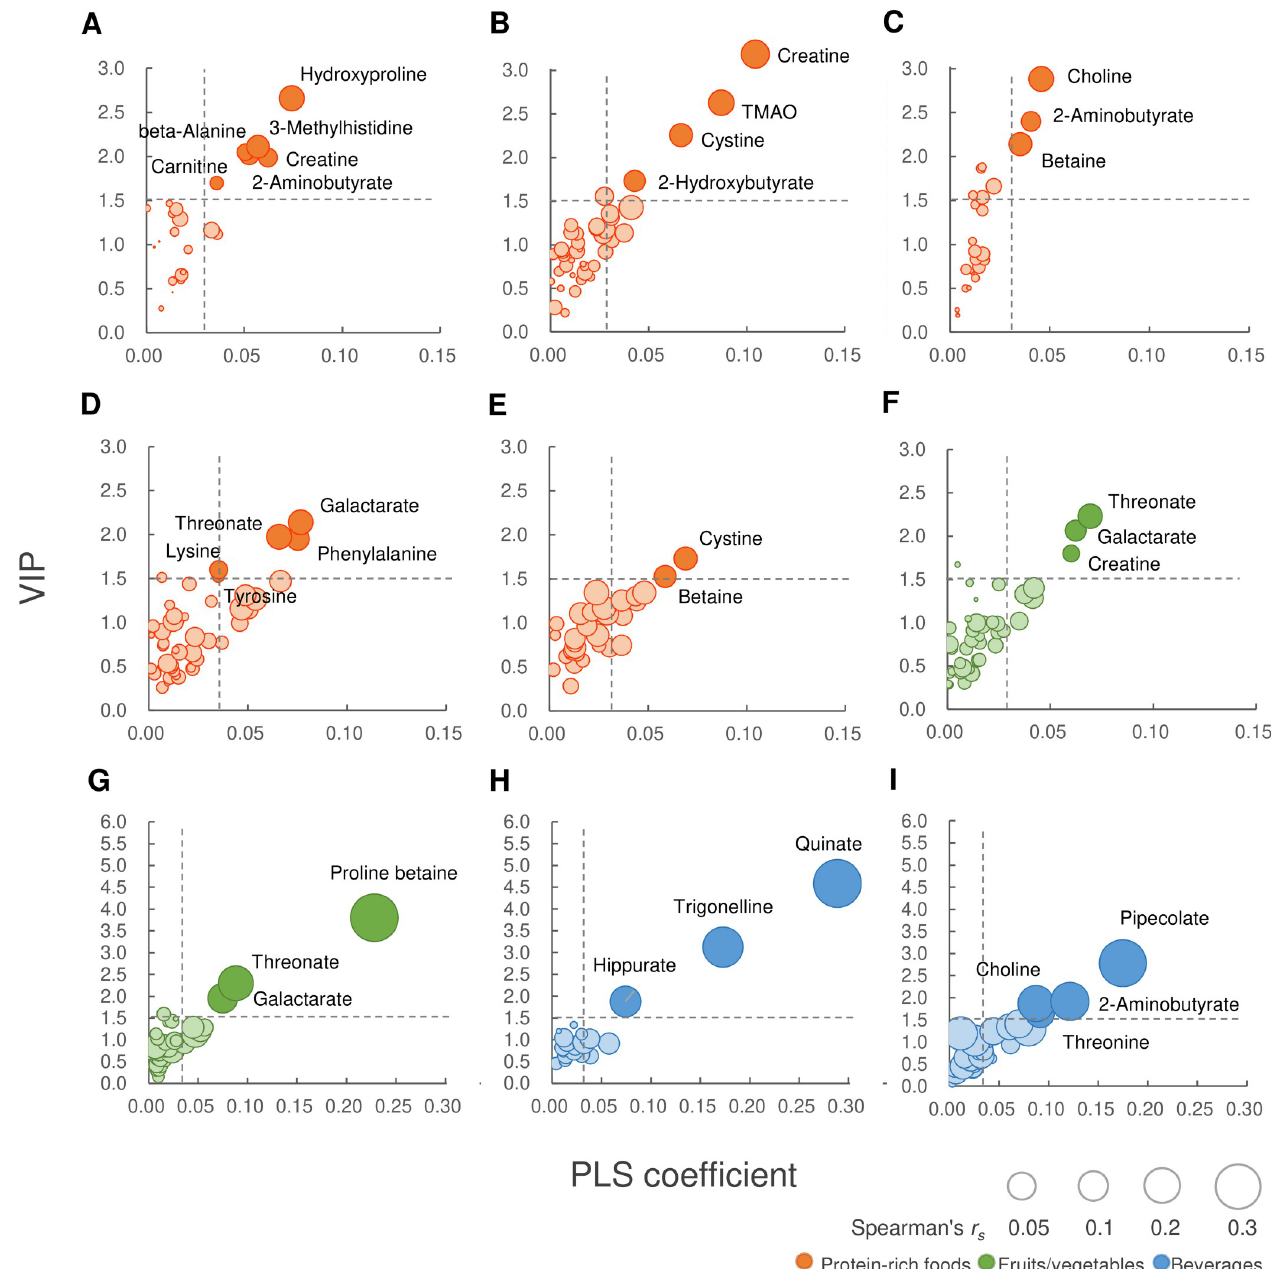
Fig 1. Overview of food biomarker candidates assessed by PLS-R (n = 7,012). Relationships between the VIP score and the PLS coefficient are described using Spearman’s correlation coefficients. The vertical axis corresponds to the VIP score, the horizontal axis corresponds to the PLS coefficient, and the area of each circle corresponds to the correlation coefficient. Notable metabolites with VIP scores � 1.5 and PLS coefficients � 0.03 are highlighted. (A) meat, (B) fish/seafood, (C) eggs, (D) dairy, (E) soy products, (F) carotenoid-rich vegetables, (G) fruits, (H) coffee, and (I) alcohol. PLS-R, partial least square regression; VIP, variable importance in projection; TMAO, trimethylamine- N